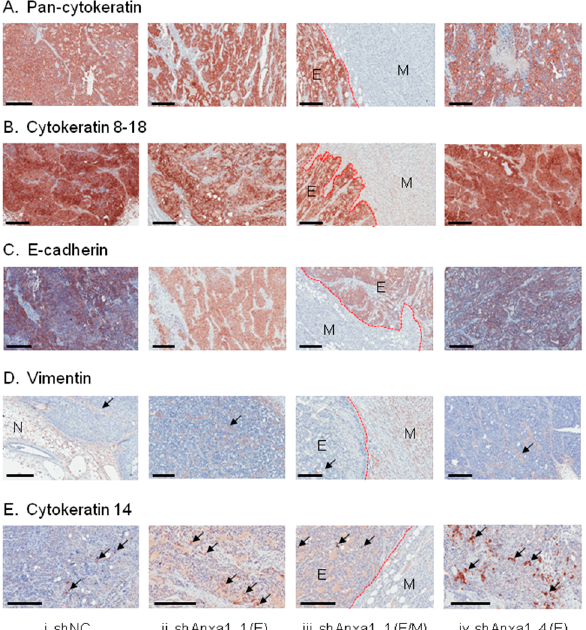
Figure 7. Immunohistochemical analysis of control PyMTneoLUC_shNC, PyMTneoLUC_shAnxa1_1, and PyMTneoLUC_shAnxa1_4 mammary tumor allografts. Tumors formed in C57BL/6NTac;B10(Cg)-Rag 2tm1Fwa Il2rg tm1Wjl immuno-deficient mice by the indicated PyMTneoLUC-derived stable transfectants were stained for ( A ) pan-cytokeratin, ( B ) cytokeratin 8–18 ( C ) E-cadherin, ( D ) vimentin, ( E ) cytokeratin 14. Representative epithelial ( E ) zones from PyMTneoLUC_shAnxa1_1 ( ii ) and PyMTne- oLUC_shAnxa1_4 ( iv ) tumors including the border region are shown, demarcating the epithelial ( E ) and mesenchymal (M) zones of PyMTneoLUC_shAnxa1_1 tumors ( iii ). ( D ). Arrows indicate vimentin- positive stromal cells. ( E ) Arrows indicate examples of small clusters of cytokeratin-14-positive cells. N, normal mammary gland. Scale bars represent 200 µ